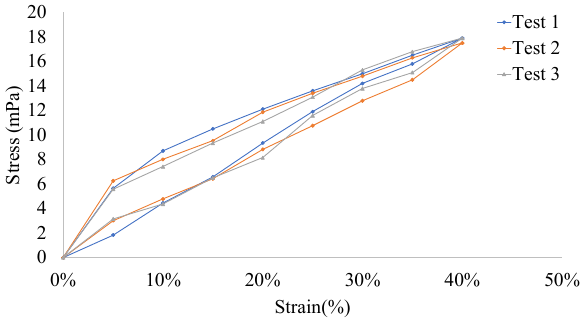
Figure 8. Hysteresis ring for flexible self-powered strain sensor.